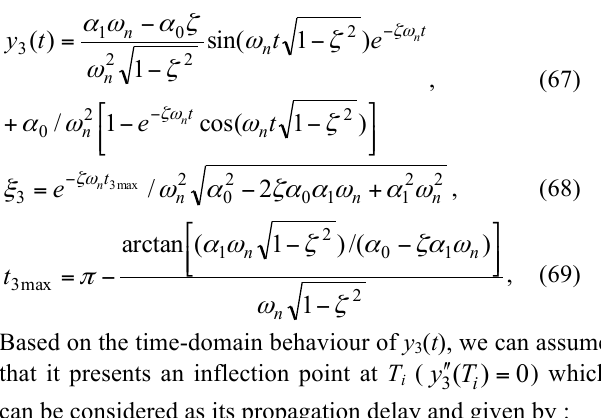
Figure 17: Photograph of the RCNGD-circuit